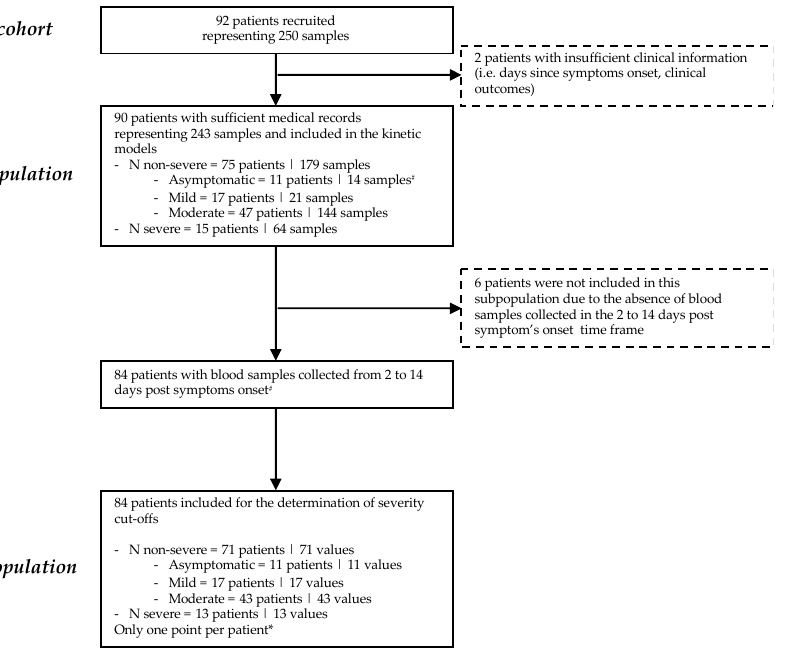
Figure 1. Study flow diagram. # In some kinetic models, asymptomatic patients and patients with positive SARS-CoV-2 spike immunoglobulin G were excluded. * Multiple sample inclusion criteria were applied to investigate different possible cut-offs for severity: (a) earliest antigenemia value since symptom onset within the day 2 to day 14 window for a particular patient; (b) mean of all antigenemia values of samples collected within the day 2 to day 14 window for a particular patient; and (c) the maximal antigenemia value obtained within the day 2 to day 14 window. All these inclusion strategies reported one value per patient (see Supplemental Figure S2).